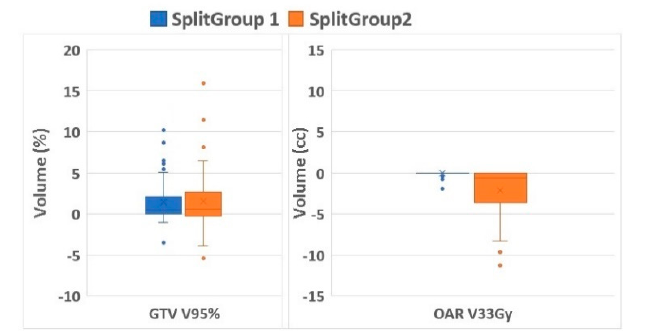
Figure 4. Difference of DVH parameters. Boxplots showing the relative volume difference in GTV Figure 4. Di ff erence of DVH parameters. Boxplots showing the relative volume di ff erence in GTV V 95% V 95% (%) and absolute difference in OAR V 33Gy (cc) of the re-optimized compared to the predicted plans (%) and absolute di ff erence in OAR V 33Gy (cc) of the re-optimized compared to the predicted plans stratified for Split group 1 (re-optimization not needed) and 2 (re-optimization needed). Abbreviations: DVH = dose volume histogram, GTV = gross target volume, OAR = organs at